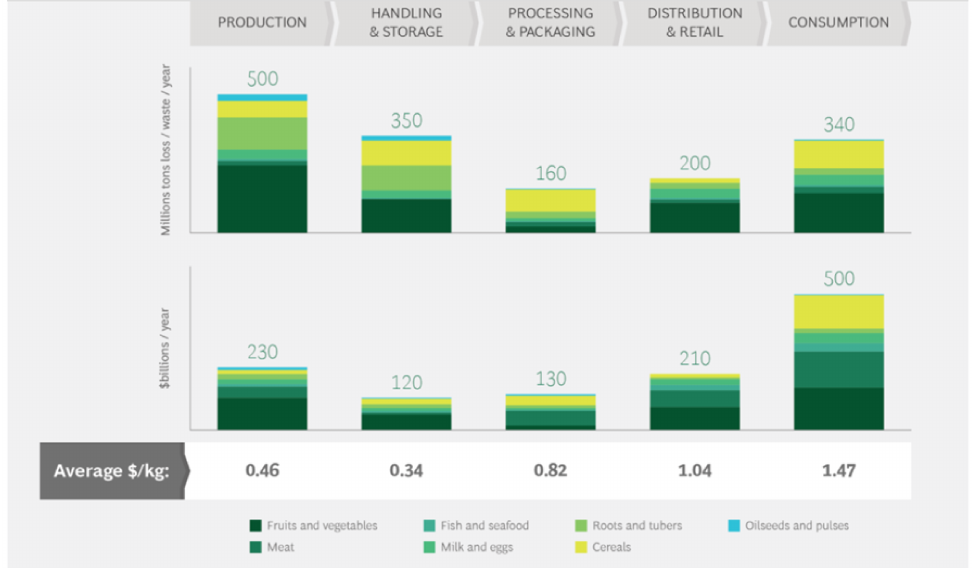
Figure 1. Food loss and waste occur across the value chain. Source: